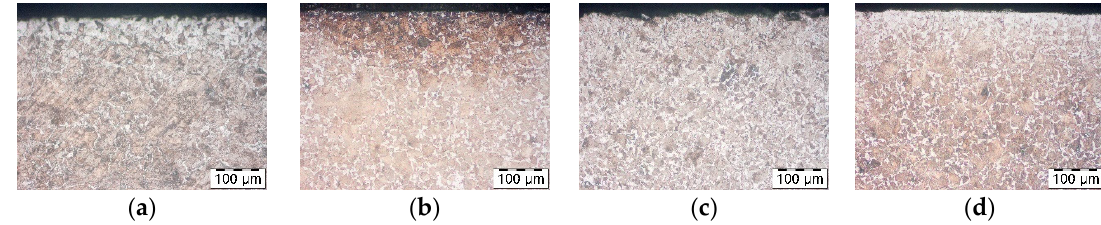
Figure 4. Microstructure in the surface layer of steel C45 after 5 min of heating in temp 1200 °C: ( a ) no coating, ( b ) Berulit, ( c ) Bonderite and ( d ) Condursal.